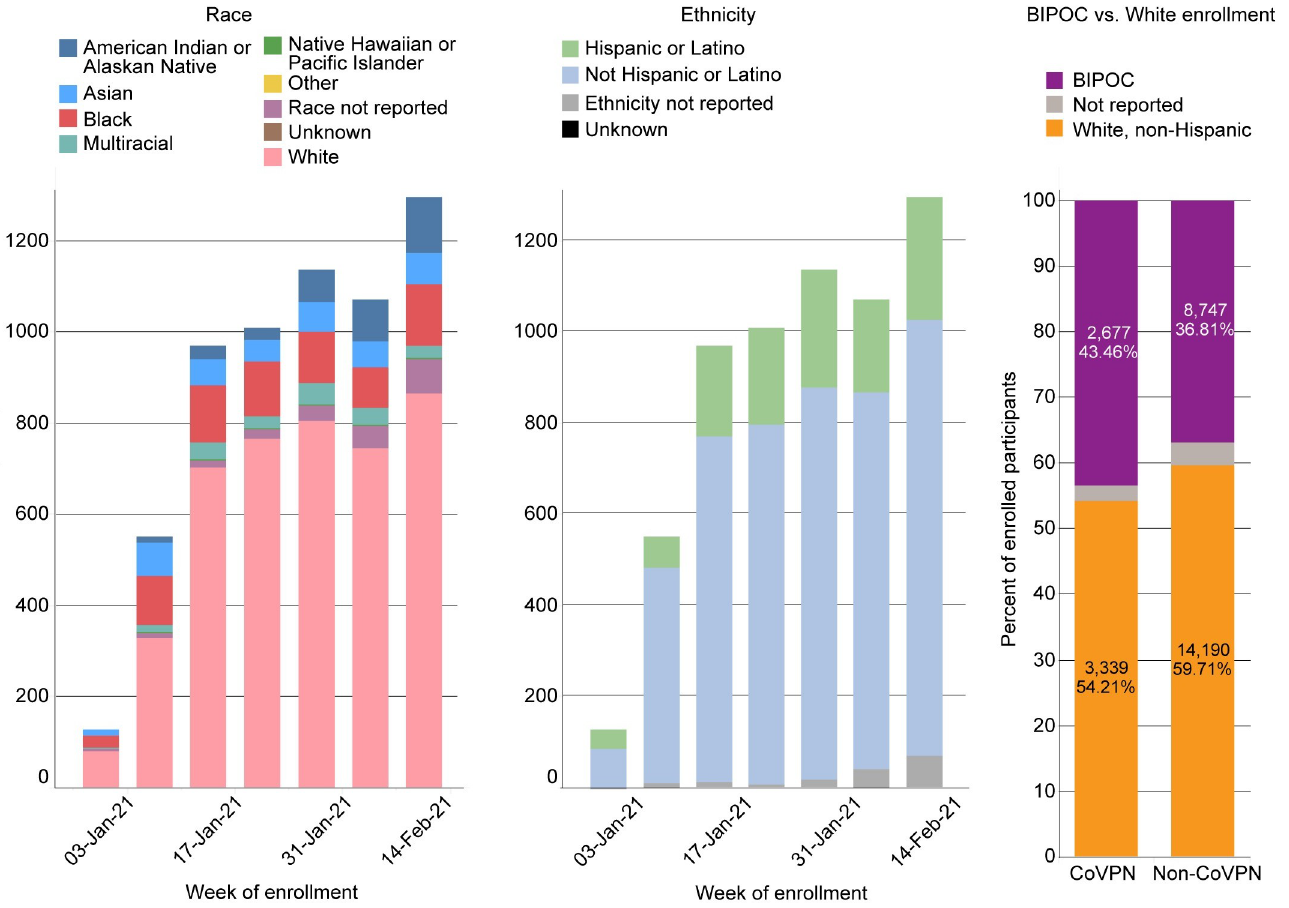
Fig 5. Novavax study enrollment. (A) Counts reflect participants who completed study visit 2 or 2.1.